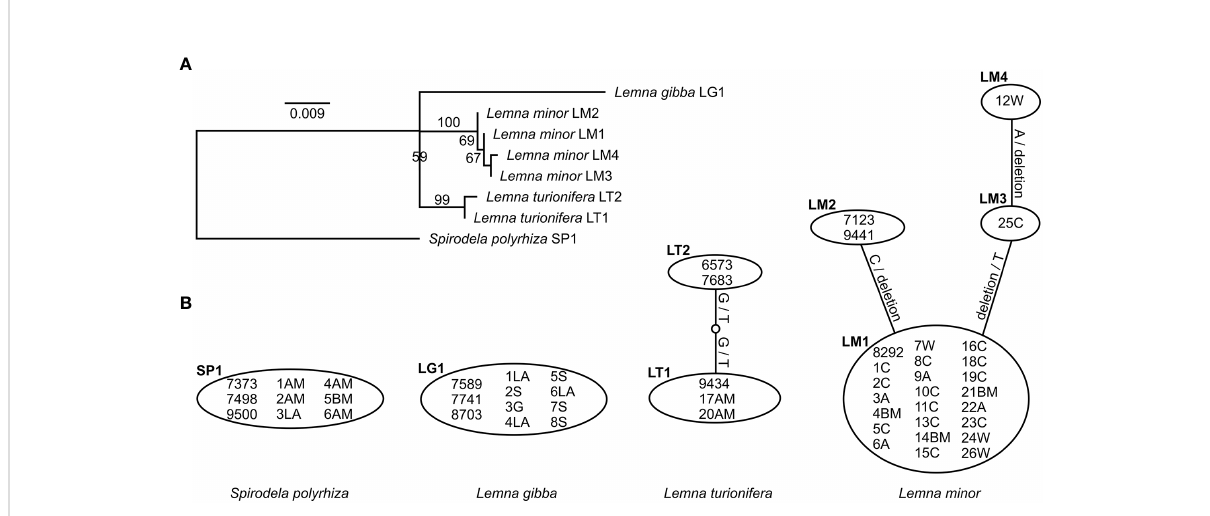
FIGURE 2 Molecular genetic results of the cp marker rps16 . (A) Maximum-likelihood tree of unique haplotypes found for all investigated clones. Bootstrap values based on 1,000 replicates. Spirodela polyrhiza was set as outgroup. Scale indicates number of substitutions per site. (B) Identi fi cation of haplotypes and their differences for all investigated clones. Substitutions are given on the lines. - denotes deletion.